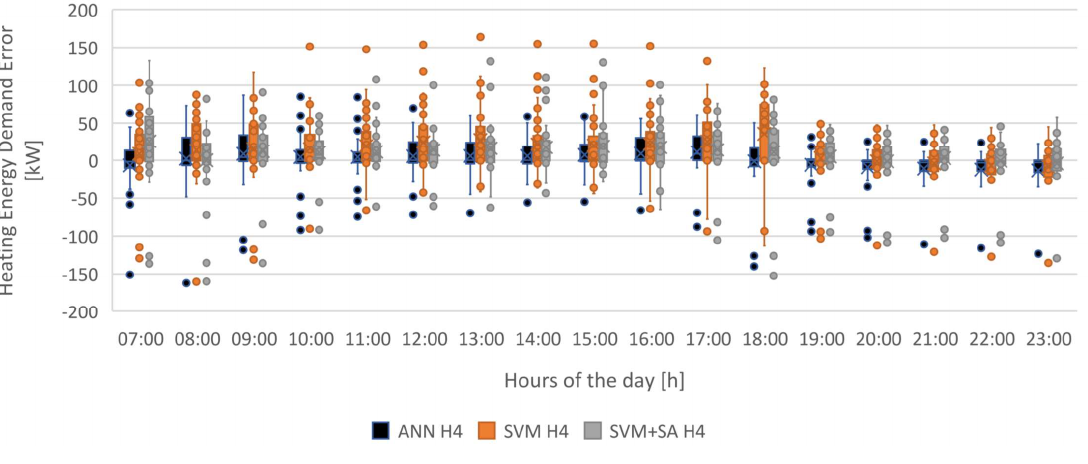
Figure 27. Error distribution for the best performing models in the heating period. Table 4. Statistical parameters for heating energy demand